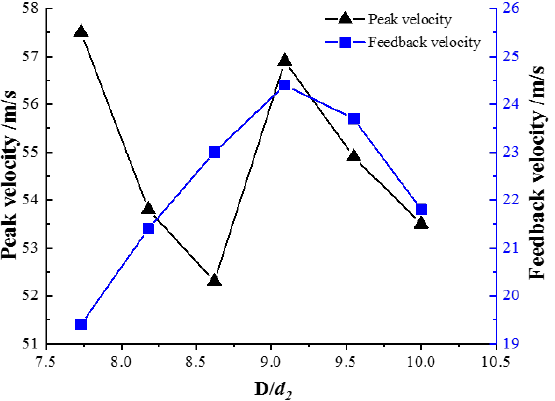
Figure 13. Curves of peak velocity and feedback velocity vs cavity diameter.